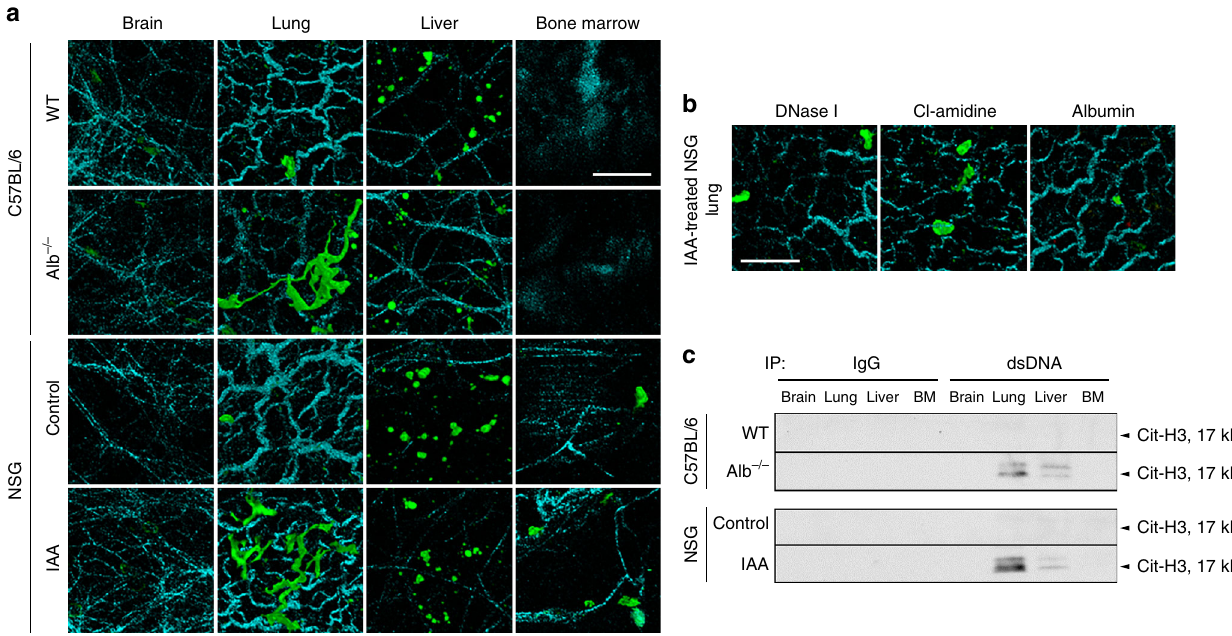
Fig. 3 NET-like structures triggered by plasma redox imbalance are lung-predominant. a – c The indicated organs were resected from WT and Alb -/- C57BL/ 6 mice and NSG mice 2 days post saline or IAA (30 mg/kg) injection with or without single injection of DNase I on day 2, daily injection of Cl-amidine, or single injection of murine albumin on day 0. a , b The resected organs were subjected to two-photon microscopy. Extracellular DNA (green) and surrounding collagen-rich parenchyma (cyan) were visualized by SytoxGreen injected via tail vein 20 min before organ harvest and by second-harmonic generation, respectively. a Representative images are shown. Bar = 40 μ m. b Representative images of the lungs from IAA-injected NSG mice with DNase I, Cl-amidine, or albumin treatment. Bar = 40 μ m. c Extracts of the organs were subjected to immunoprecipitation using an anti-dsDNA antibody followed by Western blotting using an antibody against Cit-H3. Arrows indicate the molecular weight corresponding to